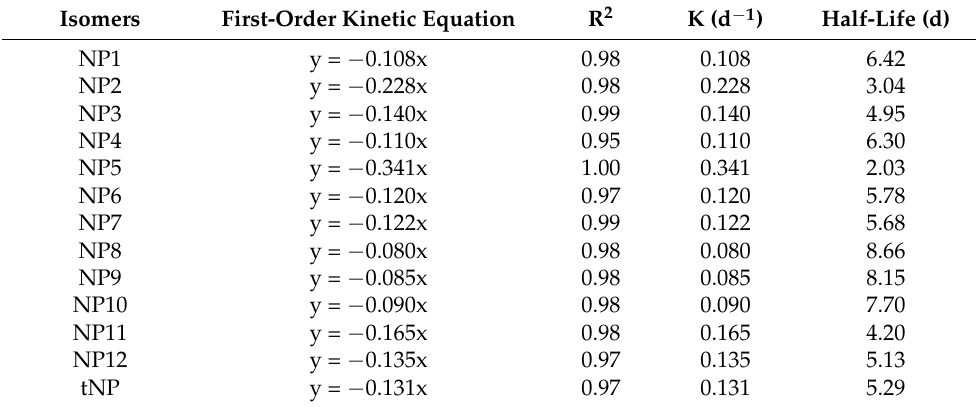
Table 1. NP degradation kinetic equations of 12 isomers in CN soil. Isomers